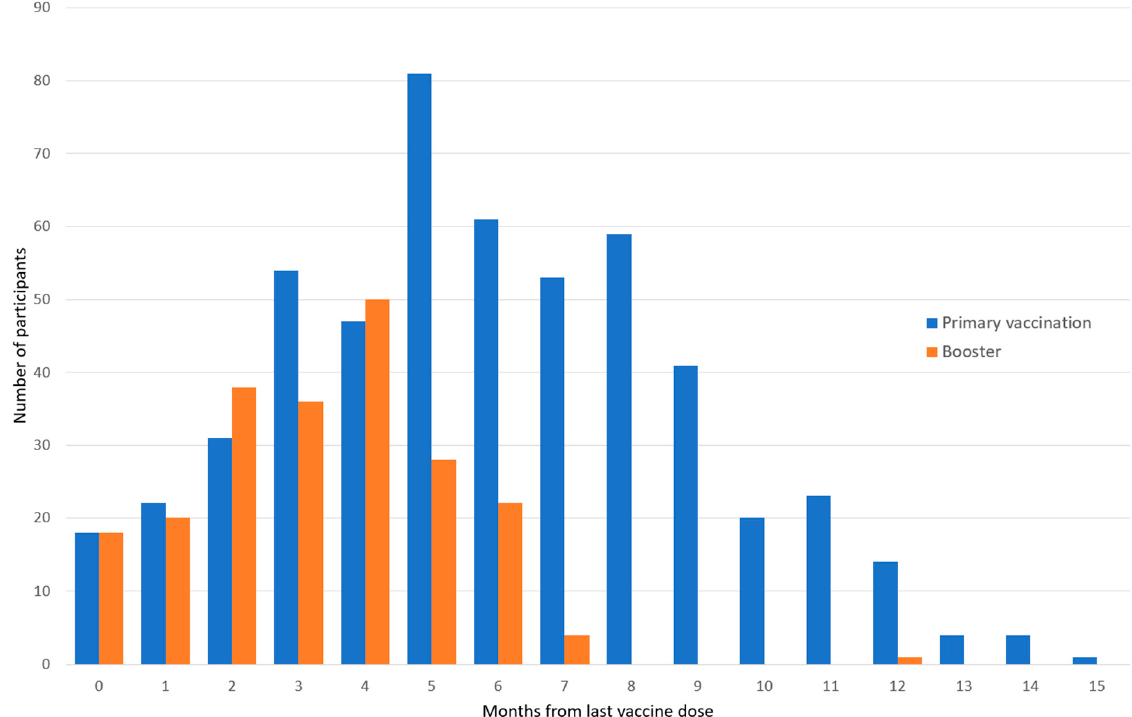
Figure 2. Time interval represented in months between the date of last vaccine administered (primary vaccination or booster vaccination) and hospitalization date.